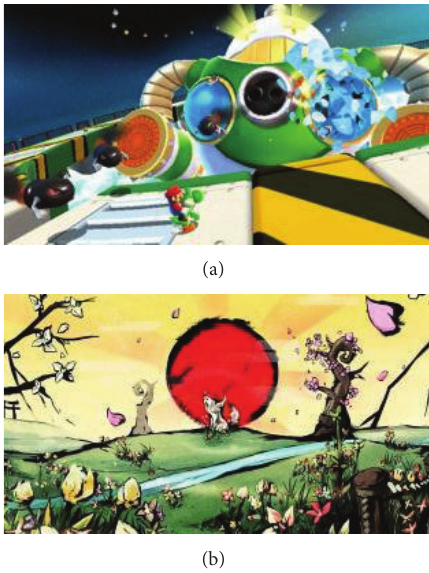
Figure 1: Two examples of modern games that use a nonrealistic visual style. (a) Super Mario Galaxy, (b) Okami.